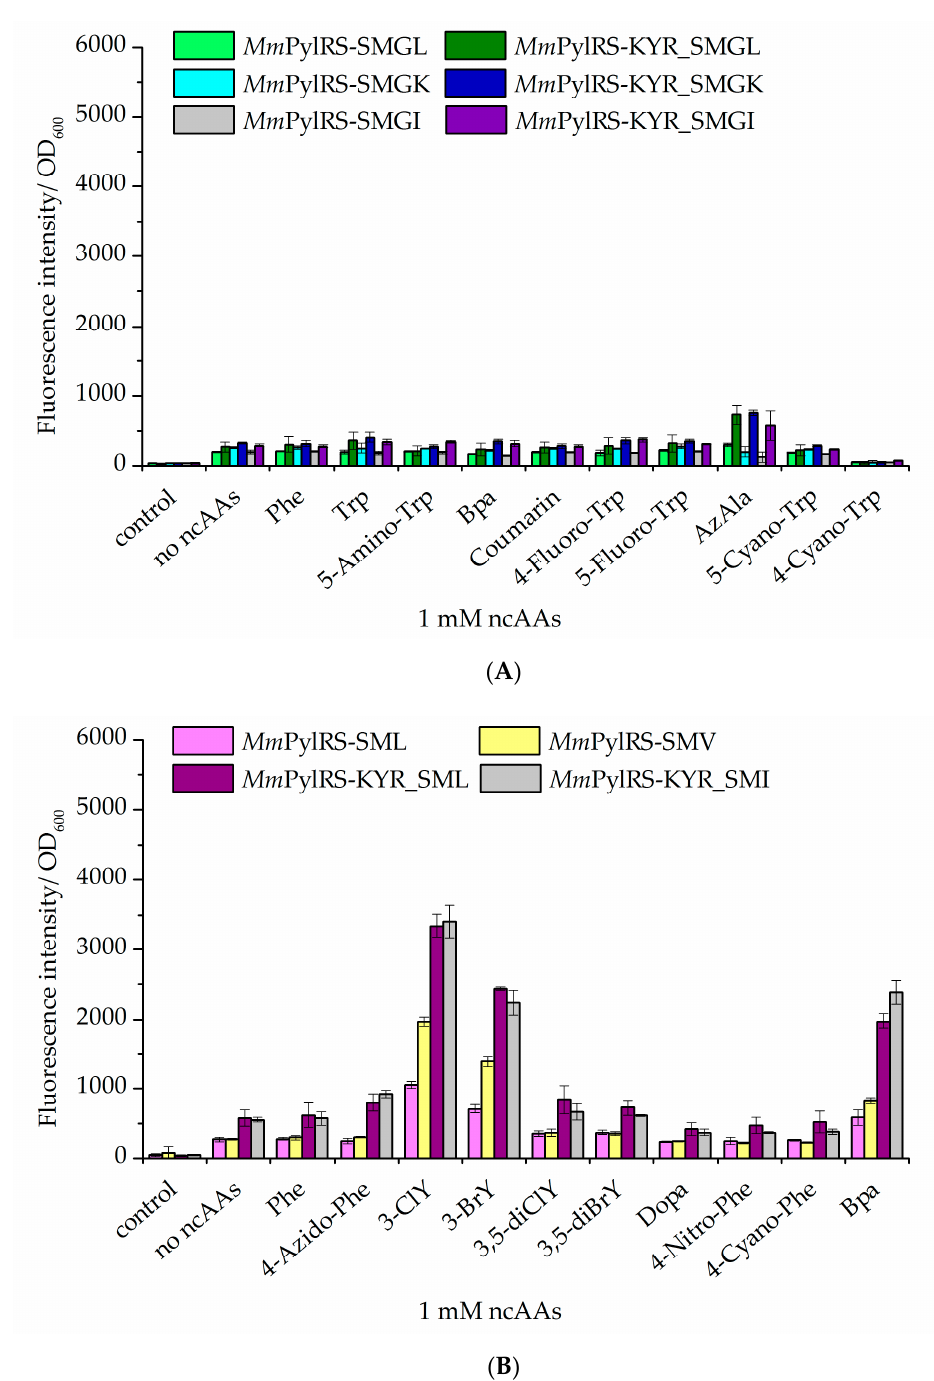
Figure 6. Comparison of ncAA incorporation via different Mm PylRS variants and impact of the activity-enhancing KYR mutation set (R61K, H63Y, and S193R). Fluorescence of the sfGFP–R2TAG reporter construct arises from amber suppression mediated by improved Mm PylRS–SMG variants. ( A ) Trp analogs were incorporated into sfGFP by different Mm PylRS variants (the last letter always